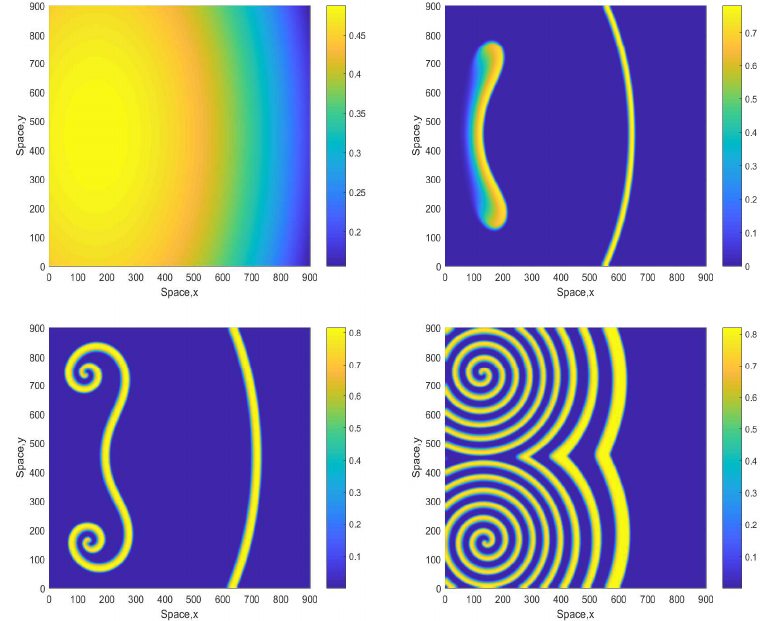
Figure 10. Spatial distribution of the oxygen concentration obtained for A = 2.5 and shown for t = 1, t = 50, t = 150 and t = 600 (left to right, top to bottom). Other parameters are the same as above. The initial conditions are given by Equations (16)–(18) with c 0 = 0.4750, u 0 = 0.3464 and v 0 = 0.1596.